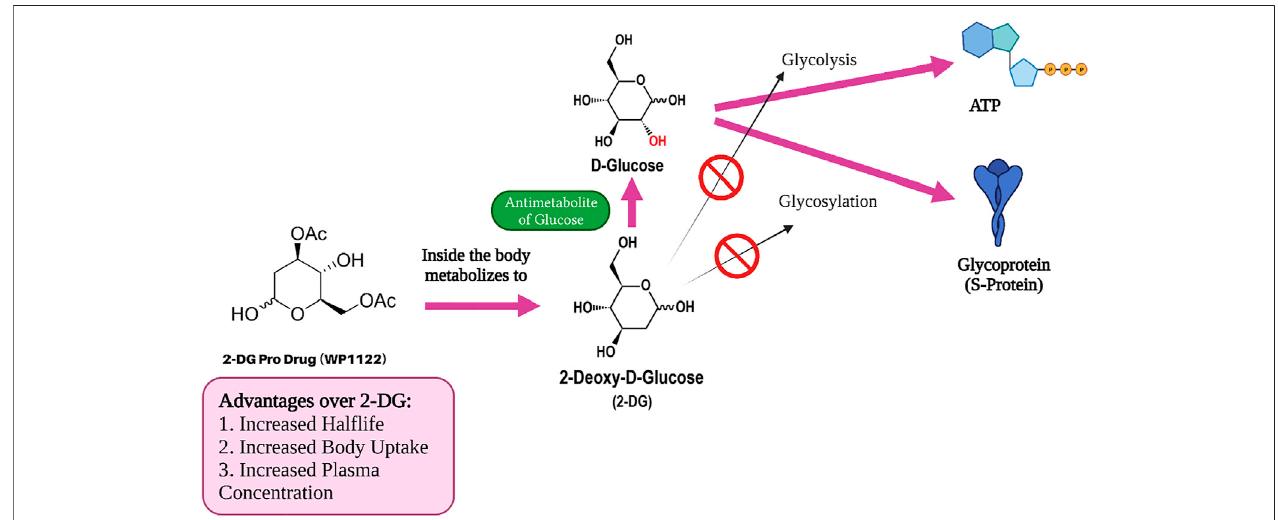
FIGURE 8 | 2-DG Prodrug and its role in inhibition of viral